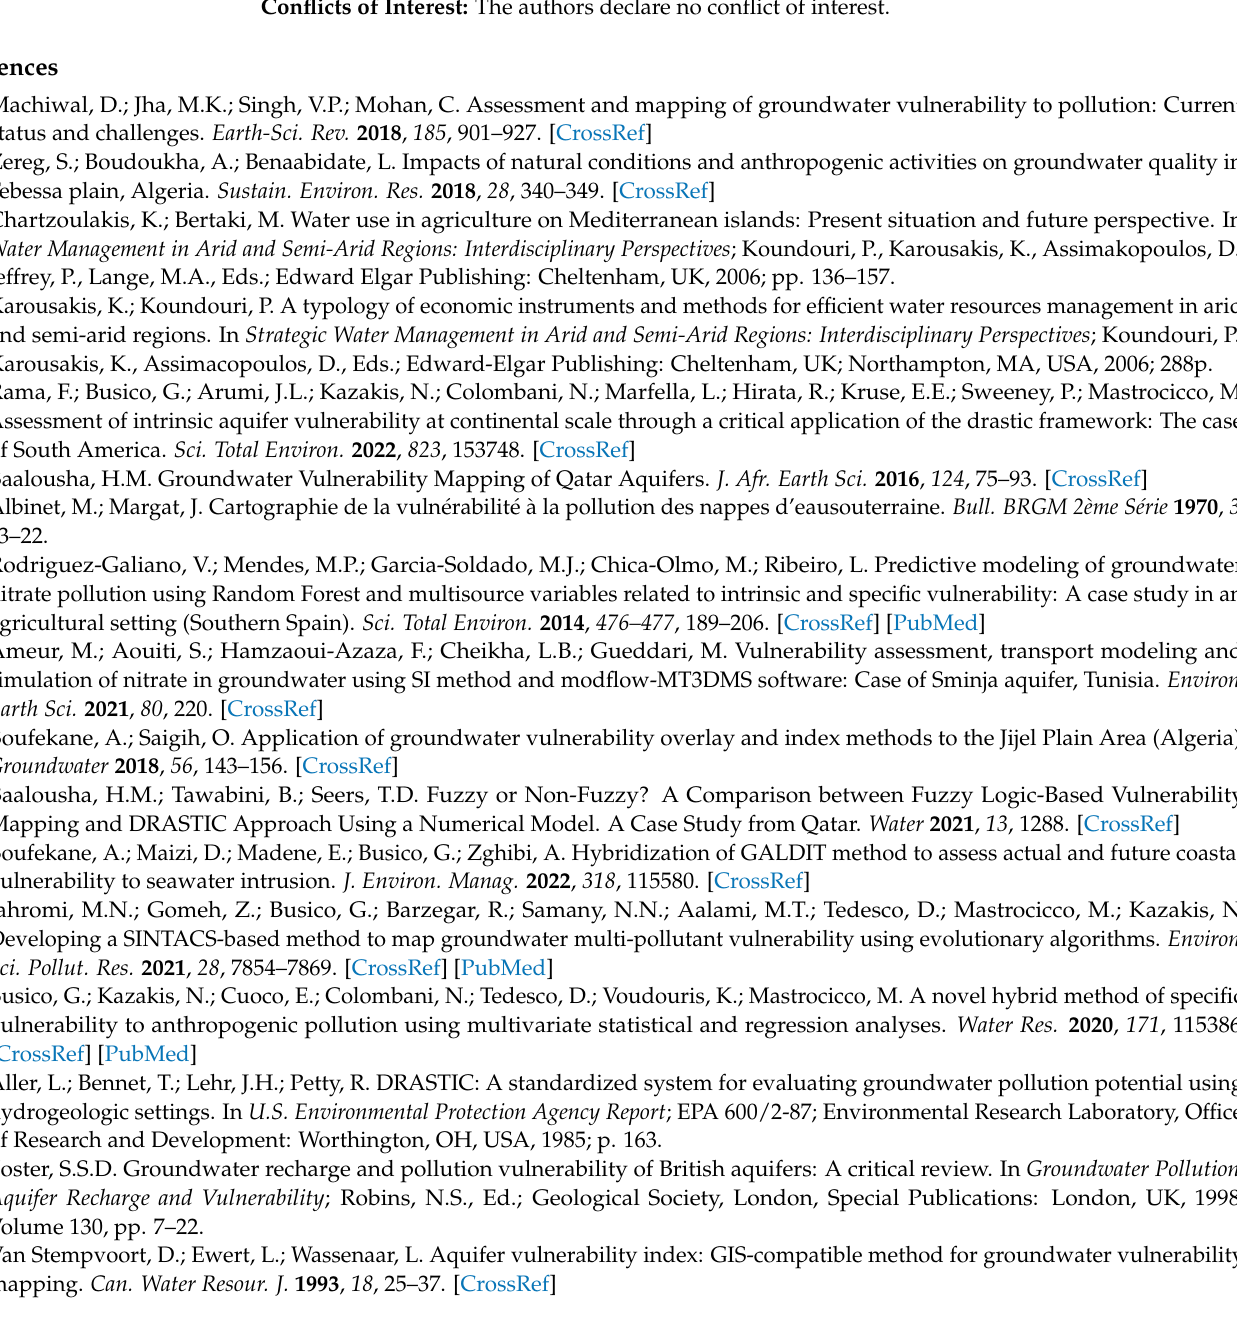
cross-section in the Tebessa-Morsott plain; Figure S4: Comparison of the DRASTIC model with the nitrate values; Table S1: Original DRASTIC weights and rating